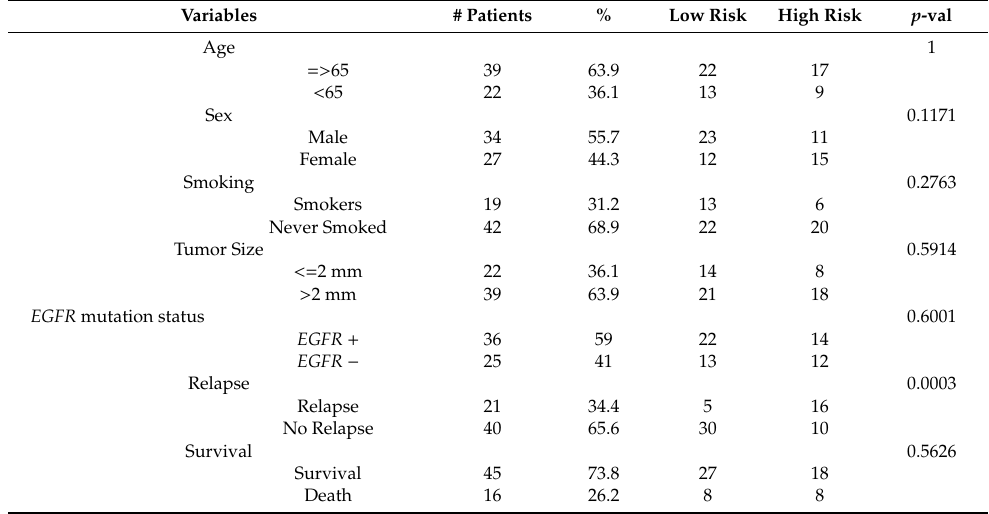
Table 1. Clinical characteristics of 61 lung adenocarcinoma patients with Stage I disease. Variables #